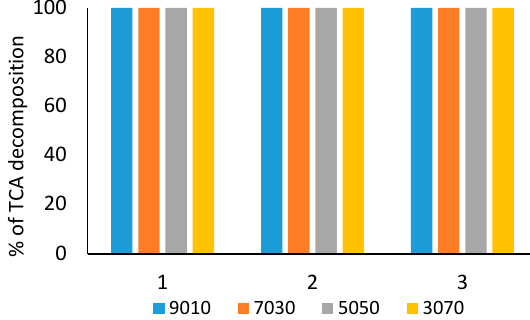
Figure 2. Decomposition of TCA after 2 h reductive dehalogenation over different SilverSil xerogels with NaBH 4 as reducing agent in 6:1 molar ratio, [TCA] = 1.4 × 10 − 3 M, [BH 4 − ] = 8.4 × 10 − 3 M.